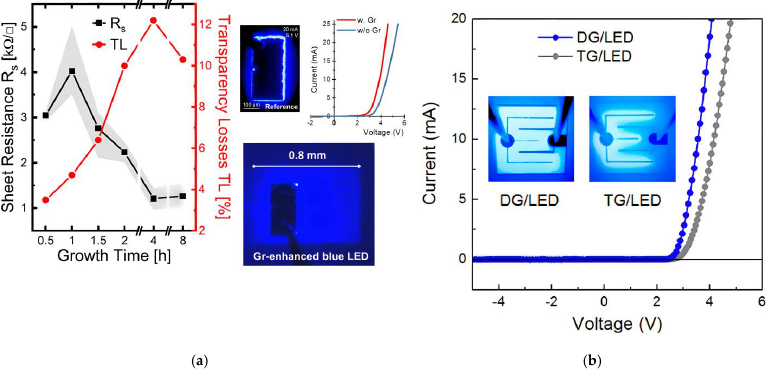
Figure 2. Directly grown graphene as TCSL integrated into GaN-based MQW LEDs: ( a ) The left panel shows the averaged value of the graphene sheet resistance (black squares) and the corresponding averaged transparency losses (red circles) as a function of growth time. The shaded areas represent the measurement errors. The right panel shows the current-voltage (I-V) characteristics and the light emission in a LED chip with graphene TCSL (red I-V curve and lower image) and without graphene TCSL (blue I-V curve and upper left image); ( b ) Optical images of light emission of a typical LED device (inset) and the I-V characteristics (plot) of a LED device with transferred graphene (i.e., TG, right inset, grey points in the I-V plot) and with directly grown graphene (i.e., DG, left inset, blue points in the plot). ( a ) Data from recent work and reproduced with permission from [68]. Chemical